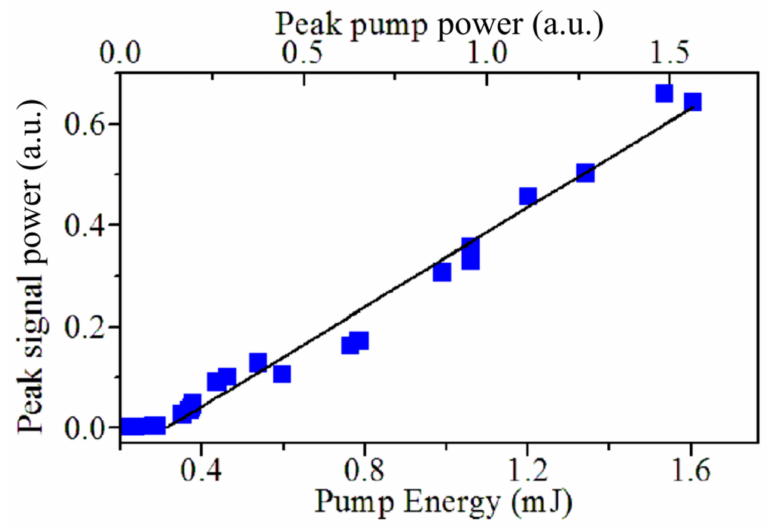
Figure 7. Efficiency of backward SRMS reflection vs. the pump pulse energy in the nanosecond interaction regime, which is measured as the peak-to-peak ratio of PD signals. Experimental points are shown by rectangles. Threshold pump pulse energy is ~0.3 mJ, the slope is